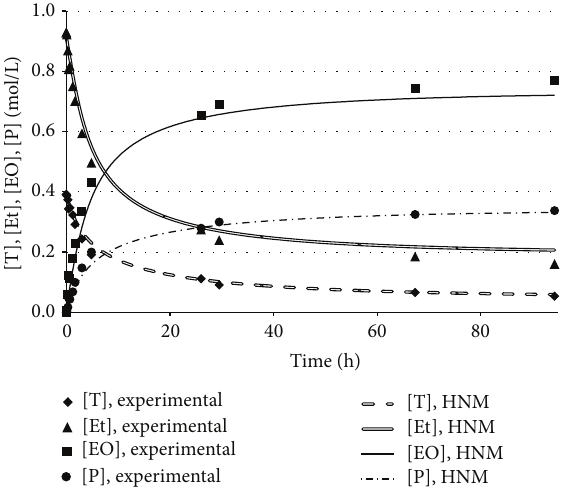
Figure 5: Comparison between the experimental data and the concentrations predicted by the hybrid neural model. Operating conditions: run 7 of Table 1.